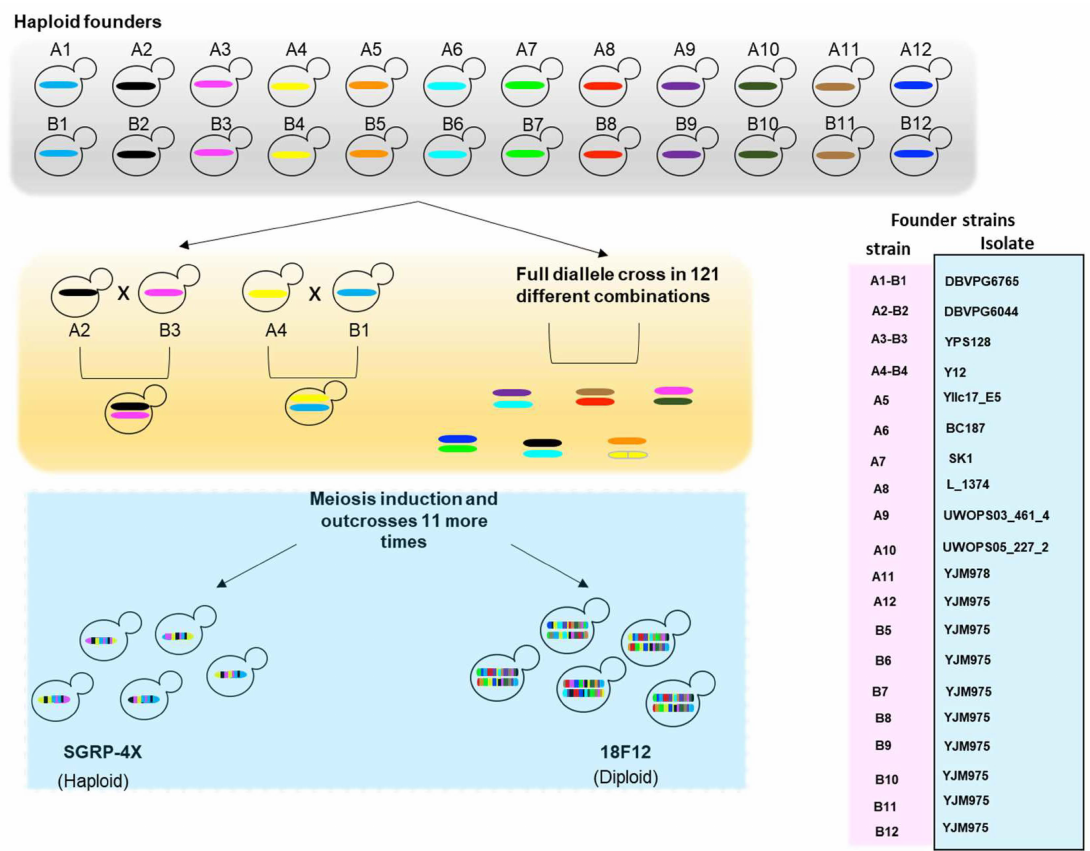
Figure 3. Cross design of SGRP-4X and 18F12 mapping populations. Haploid founder strains used for generations of these populations are indicated in the right box. Ax and Bx indicate the Mat a and Mat α haploid founder strains,